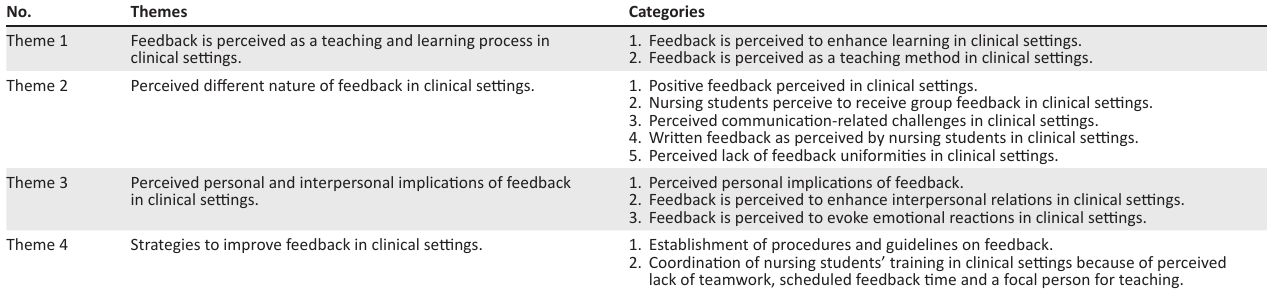
TABLE 1: Themes and categories generated from the study. No. Feedback is perceived as a teaching and learning process in clinical